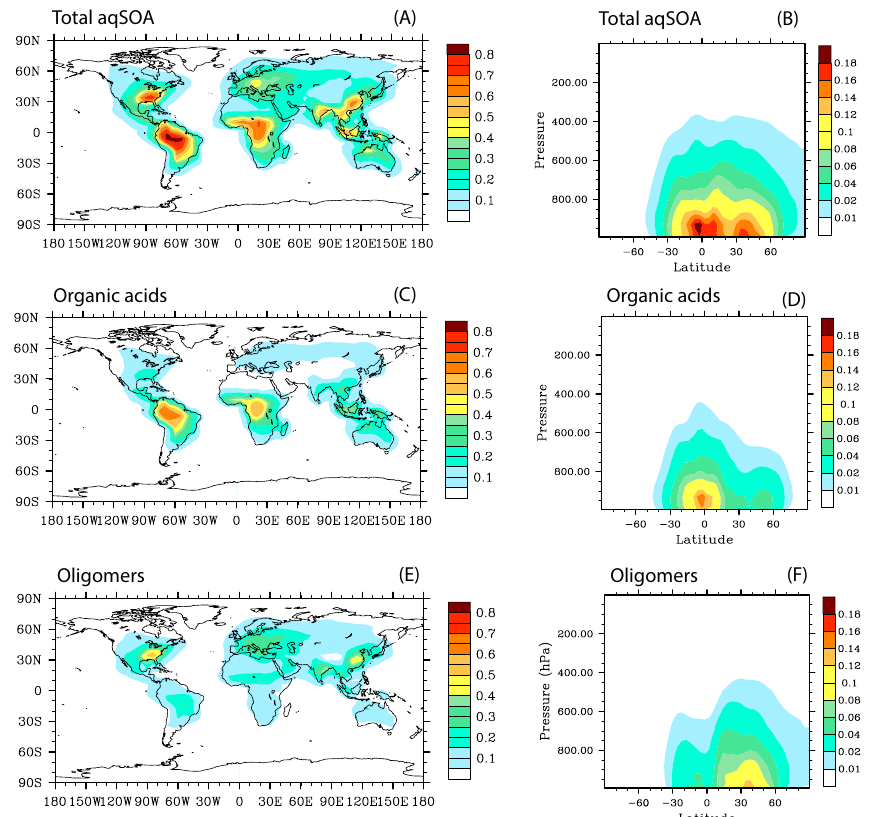
Figure 1. Annual mean simulated concentrations of total aqSOA (panel A and B), organic acids (the sum of glyoxylic acid, pyruvic acid and oxalic acid) (panels C and D), and oligomers from glyoxal and methylglyoxal (panels E and F). The left column shows the global distributions at the level of 971hPa in the model; the right column depicts the zonal mean distributions. All plots are for Case 1. Units: μg/m 3 .